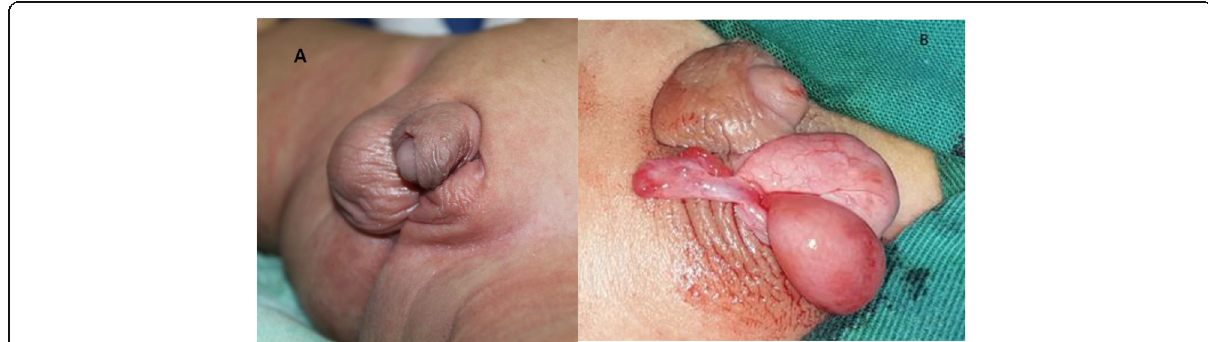
Fig. 9 a Infant with partial androgen insensitivity syndrome: left poorly developed scrotum, hypospadias with ventral chordee, and left palpable undescended testis. b Complete left epididymal